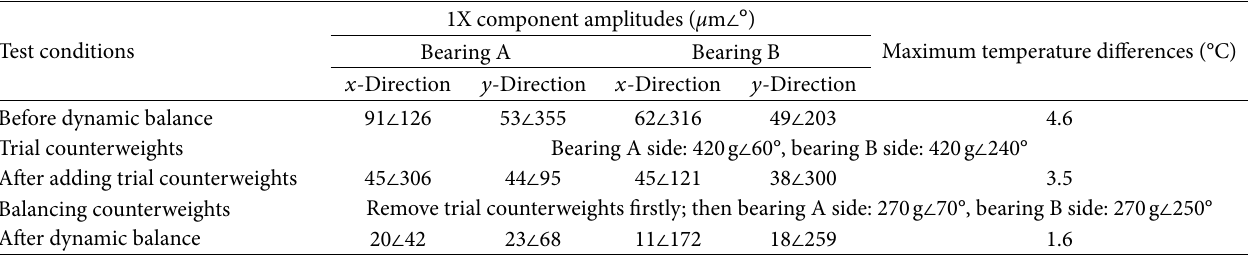
Table 4: 1X component amplitudes of shaft vibrations at bearings A and B, maximum journal surface temperature difference at bearing A.